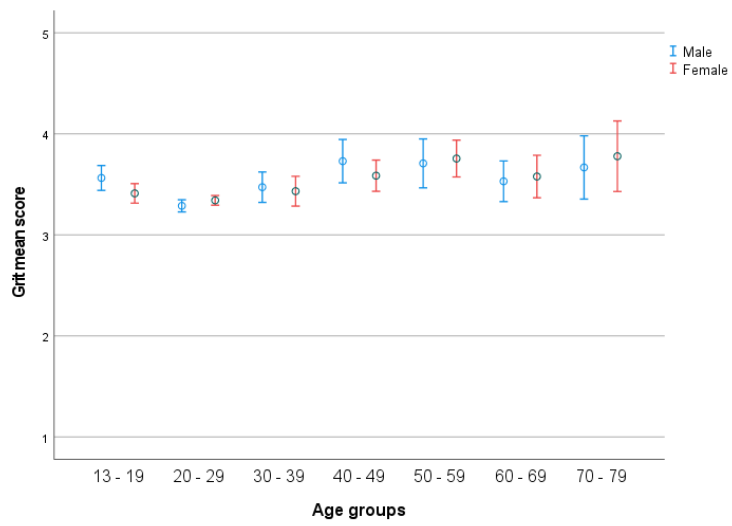
Figure 3. Grit across life-span in the seven age groups in relation to gender. Error bars represent 95 CI.